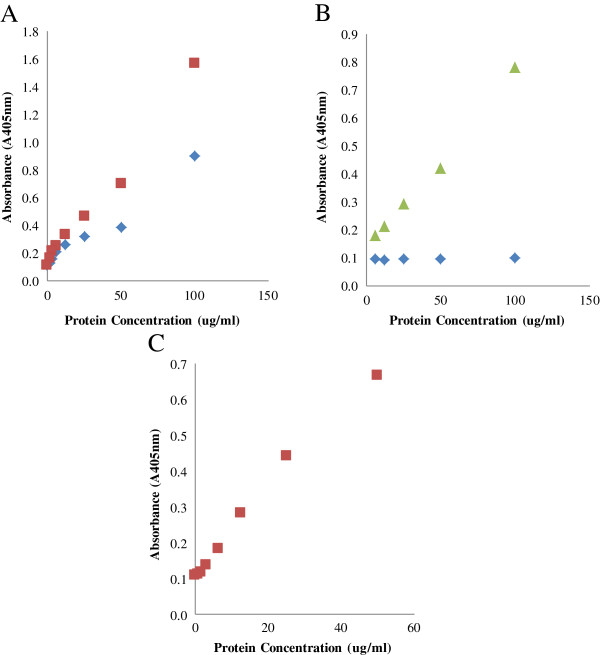
The construction of a standard curve for Cel7A ELISA (A) using whole commercial enzyme mixtures Accellerase 1000 (◊), CTec 2 (□), Cel6A ELISA (B) using Accellerase 1000 (◊) and Celluclast 1.5L (∆), and Cel7B ELISA (C) using CTec 2 (□).